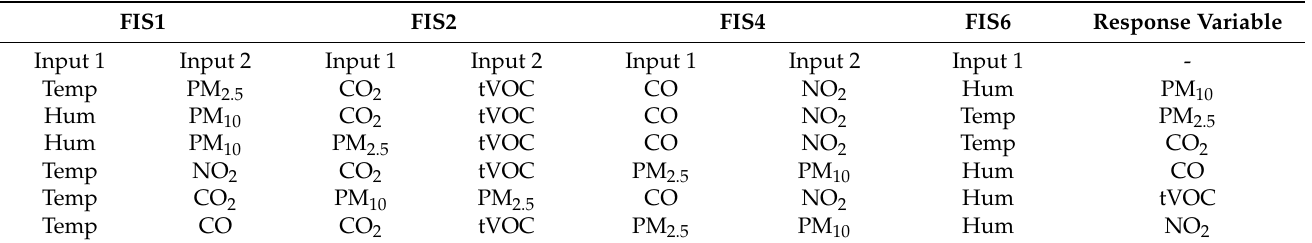
Table 3. Input feature arrangements at ADFIST system with respect to the selected response variable.